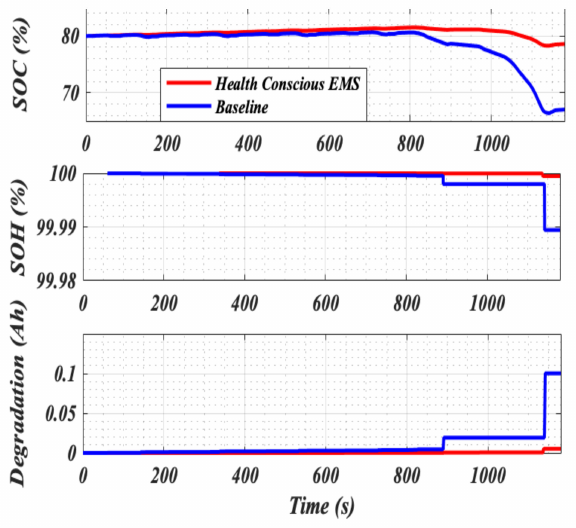
Figure 8. Battery SOC, SOH, and degradation for the WLTP